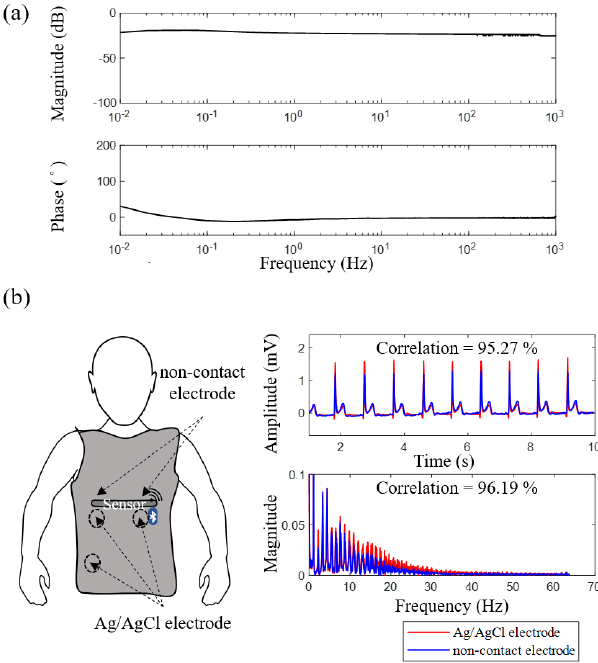
Figure 7. ( a ) Magnitude and phase responses of flexible noncontact electrode and ( b ) comparisons of ECG signals acquired by different electrodes in the time and frequency domains.